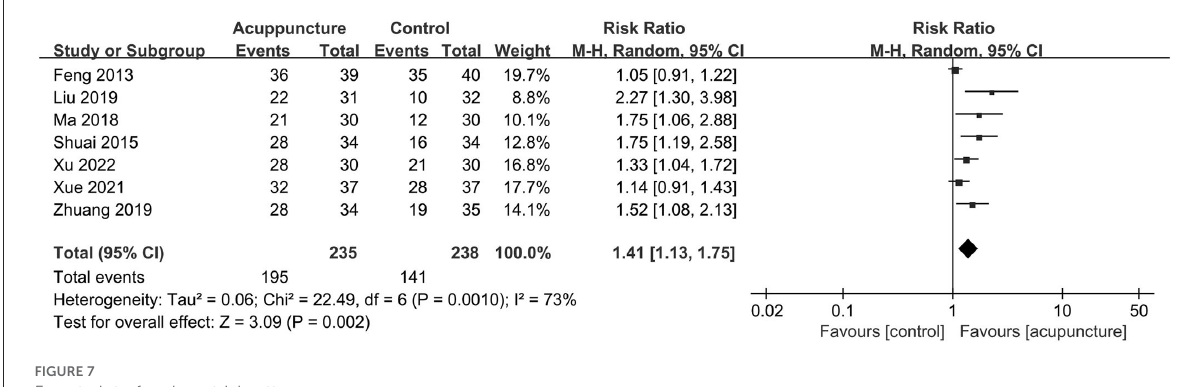
FIGURE7 Forest plot of endometrial pattern.